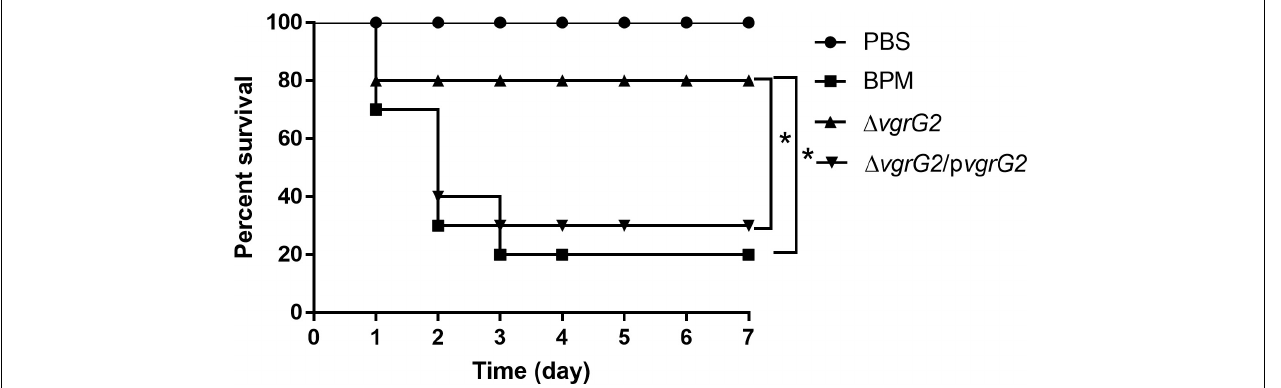
FIGURE 2 | Survival rate of BALB/c mice infected with BPM, mutant and complemented strains. The mortality of BALB/c mice after the intraperitoneal injection of all strains was observed over 7 days. Data points represent the percentage of BALB/c mouse survival in each group ( n = 10 mice per strain and 1 × 10 7 CFU per mouse). After infection for 7 days, the survival rate of BALB/c mice infected with PBS and (cid:49) vgrG was significantly lower than that of BALB/c mice infected with BPM *( P < 0.05). TABLE 3 | LD 50 of BPM, mutant and complemented strains in BALB/c mice.